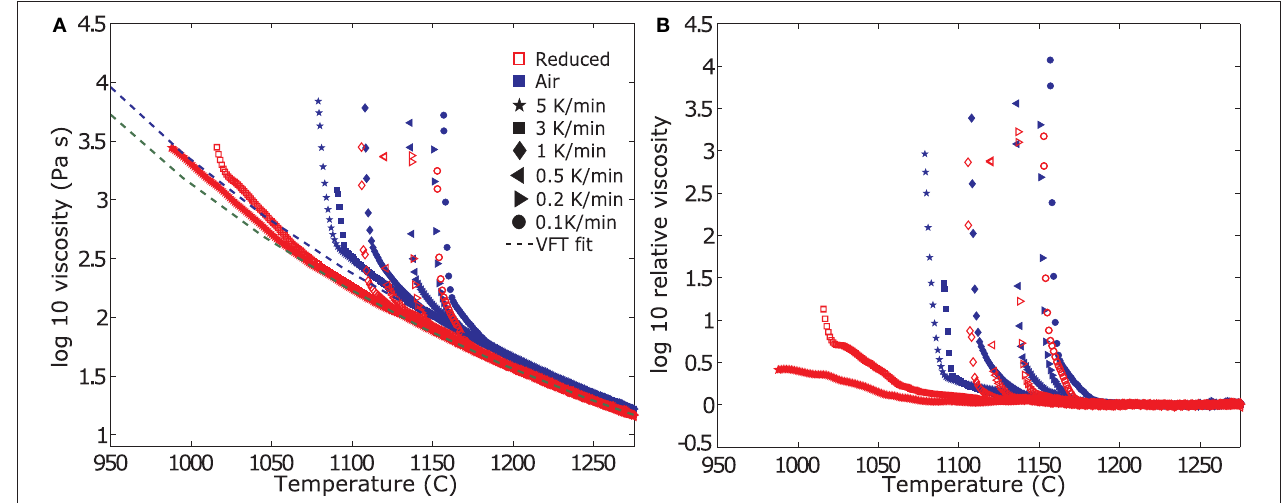
Table 2 . All measurements follow the VFT model until crystallization occurs, resulting in an increase in the apparent viscosity of the suspension. (B) Summary of the calculated relative viscosity data from the dynamic crystallization experiments plotted in (A) . The data represent the measured viscosity normalized to the VFT